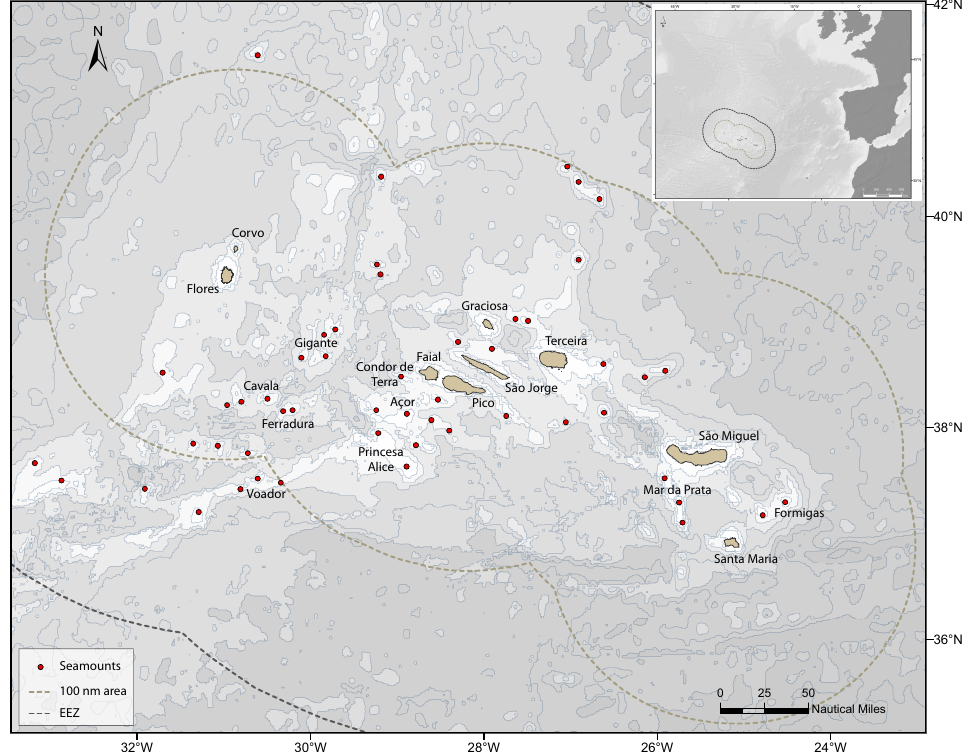
Fig. 1. Map of the study area showing the most important geomorphological features (islands and seamounts) sampled within the Azores